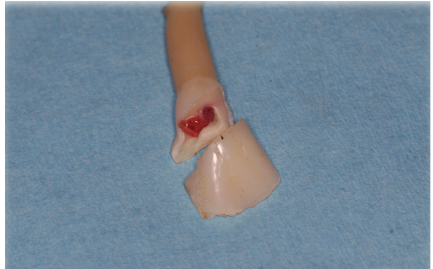
Figure 1: Fracture produced in the bovine tooth by